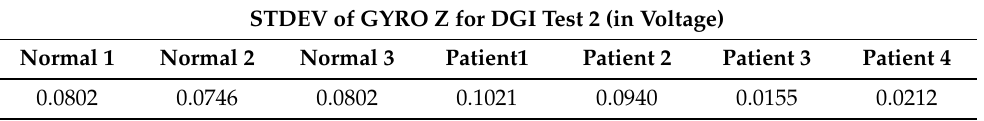
Table 4. STDEV for three normal subjects and four patients for DGI Test